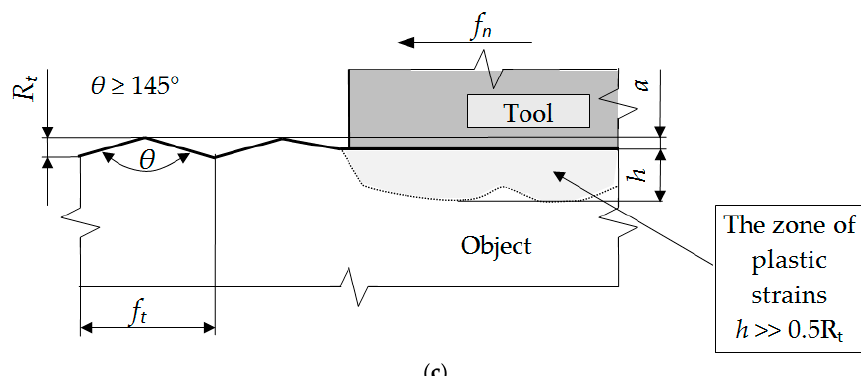
Figure 1. The influence of the vertical angle of a symmetrical triangle asperity on the depth of strain zone and surface roughness profile after burnishing: θ ≤ 80° ( a ), 80° < θ < 145° ( b ), θ ≥ 145° ( c ) [39].